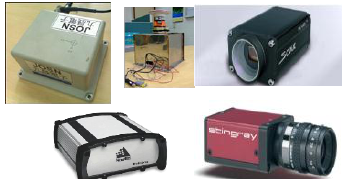
Figure 8 All sensors include SPAN-CPT system, NovAtel ProPak -V3, Basler Scout, and AVT Stingray camera.